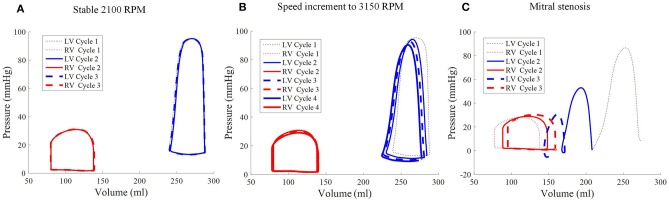
Pressure-volume loops of the biventricular model with LVAD taken at stable 2,100 RPM pump speed (A), speed increment to 3,150 RPM (B), and mitral stenosis (C). The loop shape transformed following the speed increase (cycle 2 onwards of middle figure) and introduction of mitral stenosis (C) from cycle to cycle.